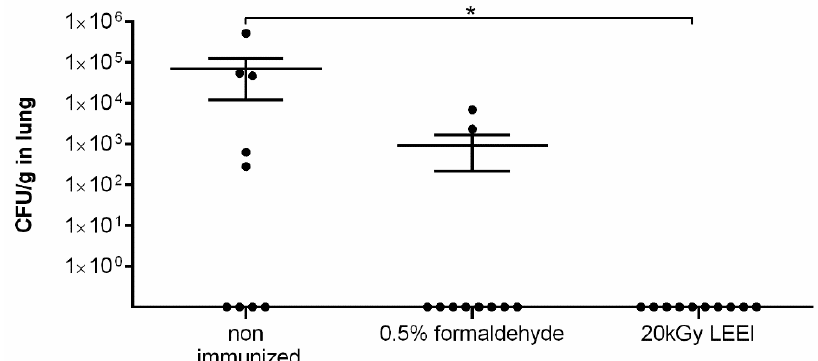
Figure 4. Bacterial load at day 15 post intranasal infection with R. pneumotropicus in the lung tissue of vaccinated and control mice. Determination of bacterial load in the lung tissue of challenged mice 15 d.p.i. by investigating colony formation after culturing homogenized lung tissue on COB at 37 °C overnight. Bacteria were inactivated as indicated for preparation of the bacterin. P -value was determined by the Mann–Whitney test. * indicates p ≤ 0.05. Means and standard deviations are indicated by lines and error bars, respectively.